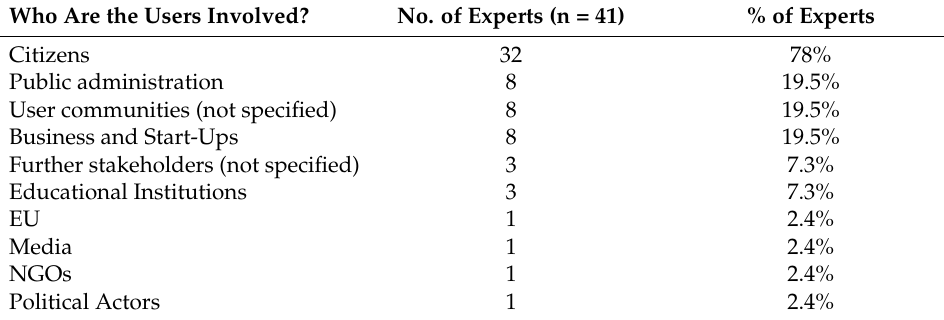
Table 3. Users in